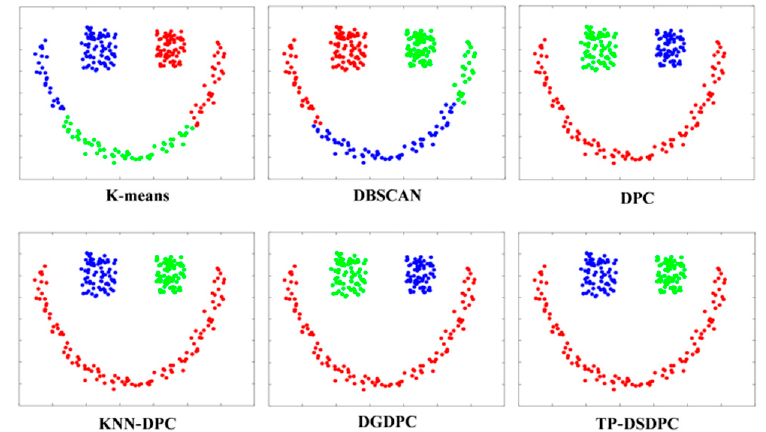
Figure 10. Clustering results on Smile.